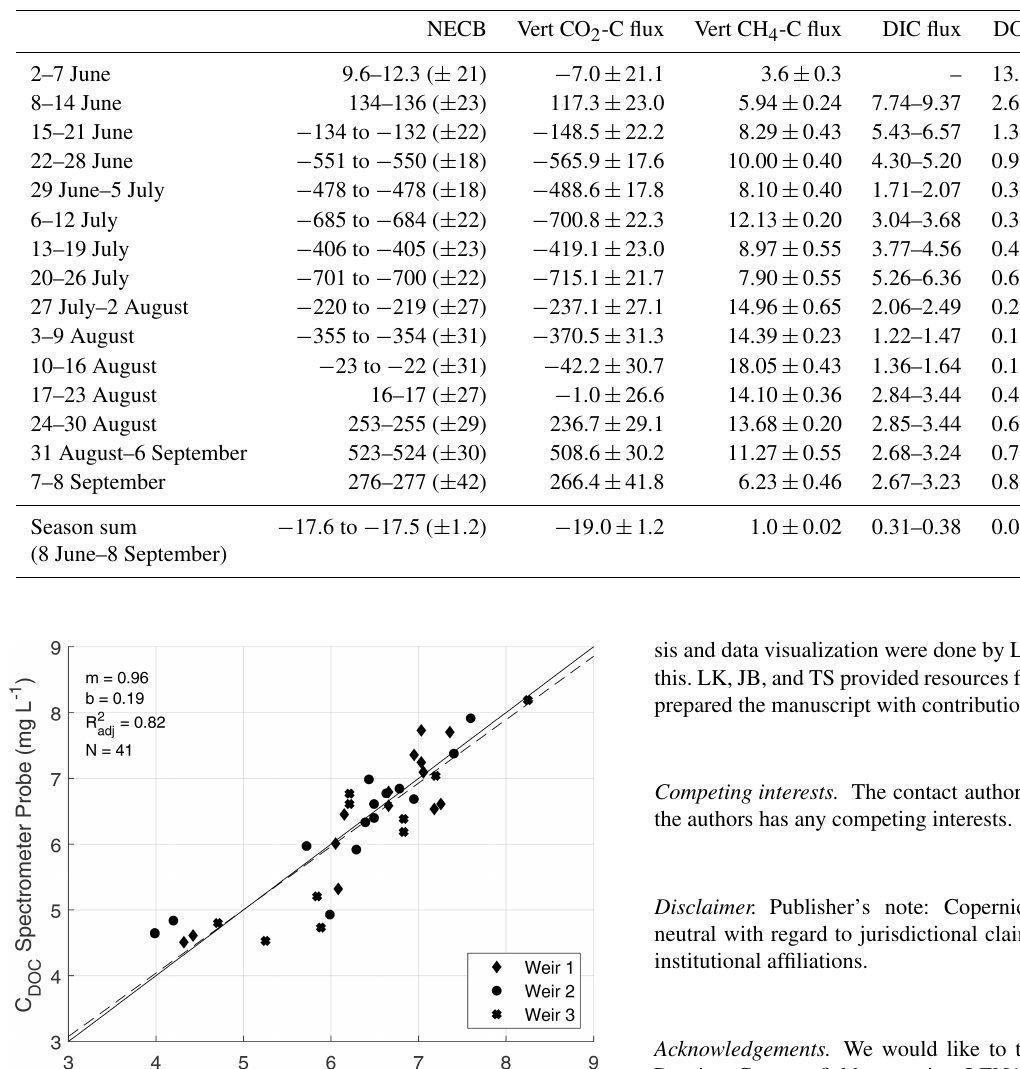
Table A1. Mean daily flux components for each week (first 15 rows) and cumulative flux components (last row) of the NECB (CO 2 -C, CH 4 -C, DIC, and DOC) during the measurement period in 2014. Uncertainties from systematic errors are shown with an en dash (–), and uncertainties from random errors are denoted by the plus–minus symbol ( ± ).